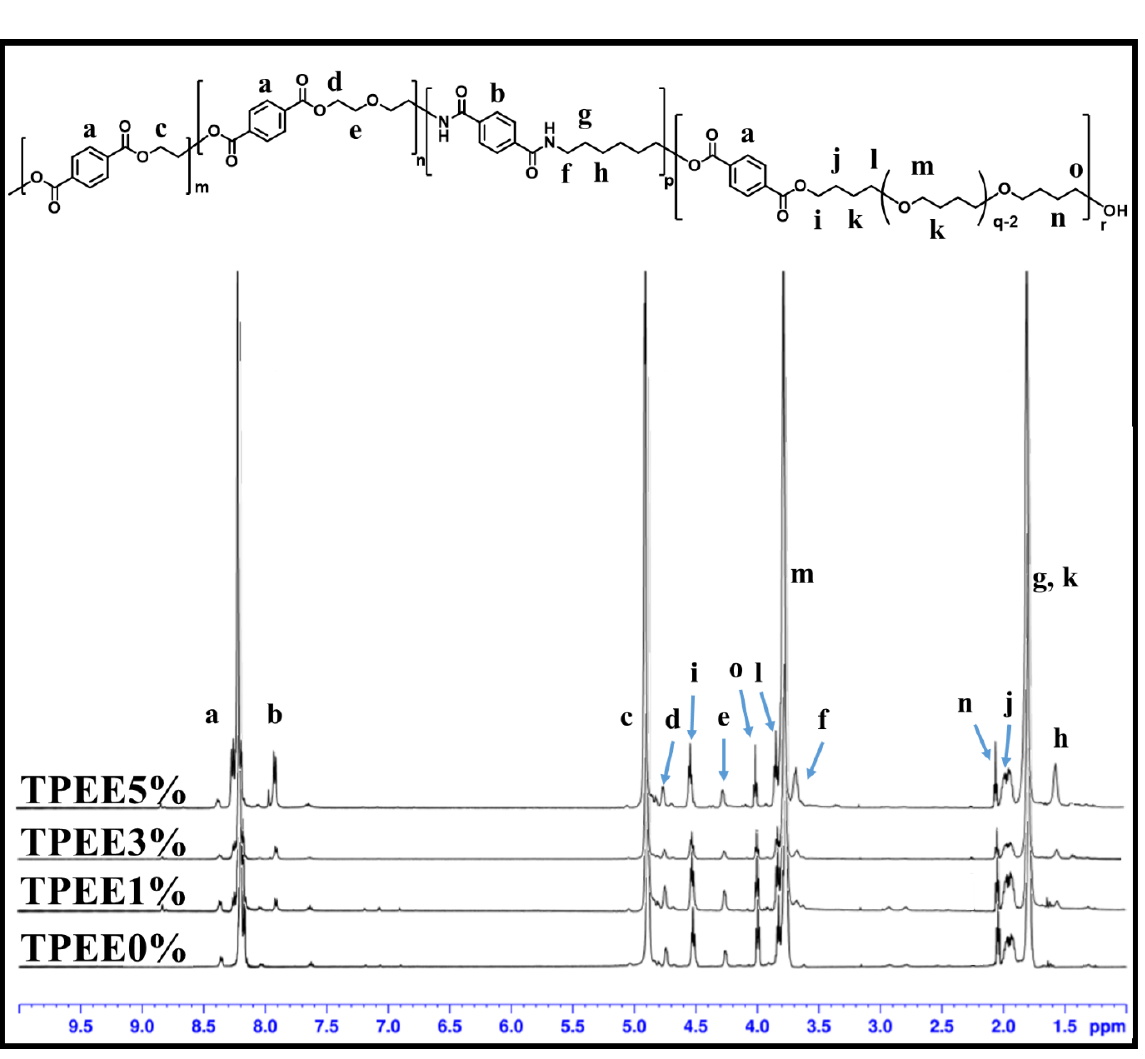
Figure 1. 1 H NMR spectra of TPEEn% (n was different amounts of HDA).